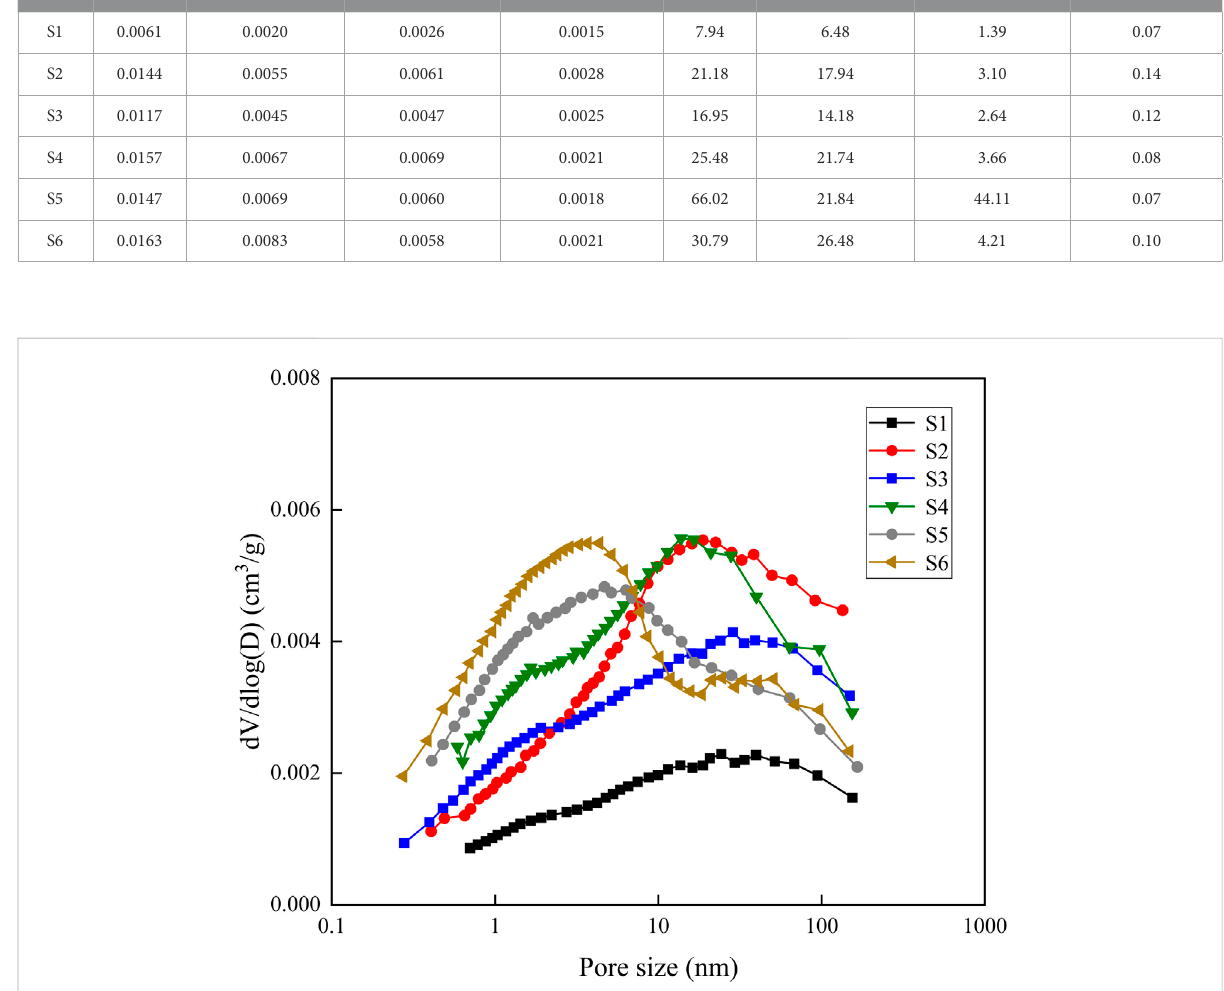
FIGURE 5 The pore size distribution of the shales identi fi ed by LT-N 2 GA measurement.